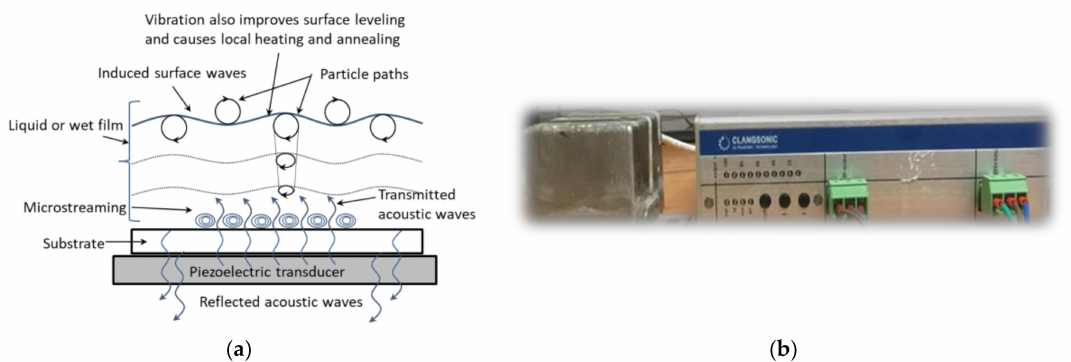
Figure 1. Schematic of ultrasonic excitation of a wet film. ( a ) Theoretical considerations and ( b ) a signal generator (right) and a vibrating box/substrate holder (left) used in the experiments. A Langevin transducer with a given frequency was welded to the inside of the top surface of the box, generating vibrations perpendicular to the film. Part ( a ) was adapted with permission from [47]. Copyright 2017